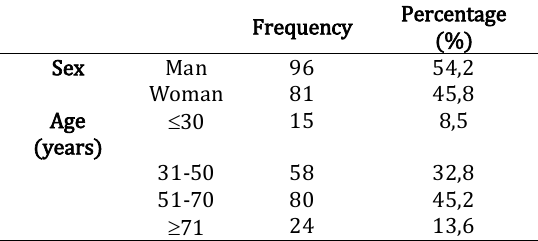
Table 2. COVID-19 patient demographic data